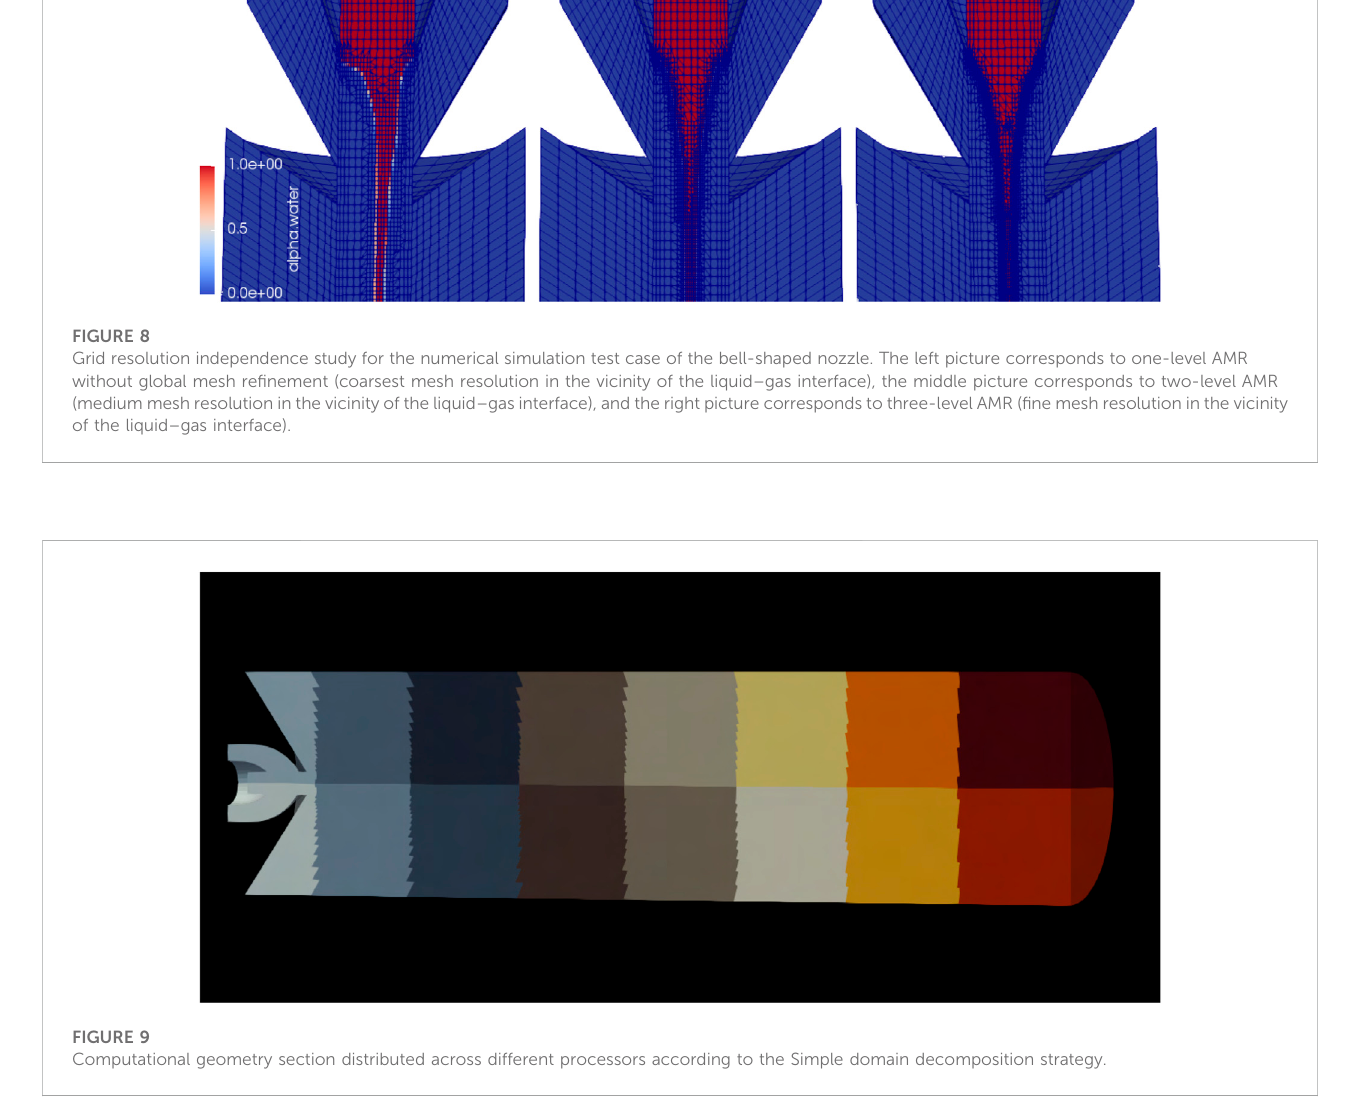
Figure 9 showing how the computational domain corresponding to the bell-shaped nozzle is decomposed to run on 16 cores be the aforementioned “ Simple ” method, and Figure 10 showing how the computational domain corresponding to the bell-shaped nozzle is decomposed to run on 16 cores be the aforementioned “ Scotch ” method. The Scotch decomposition enables the distribution of all the domains ’ cells across multiple nodes and cores. The Scotch algorithm minimizes the number of contact cells while also minimizing the difference in the number of cells for each processor.